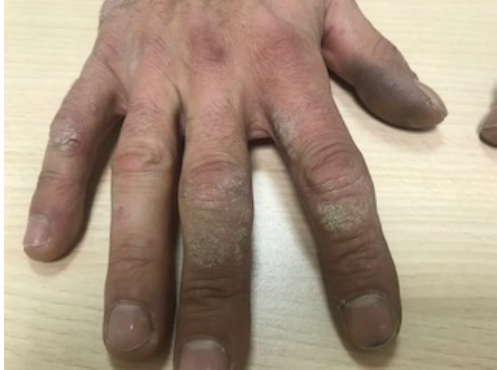
Figure 1. Hexavalent chromium allergic